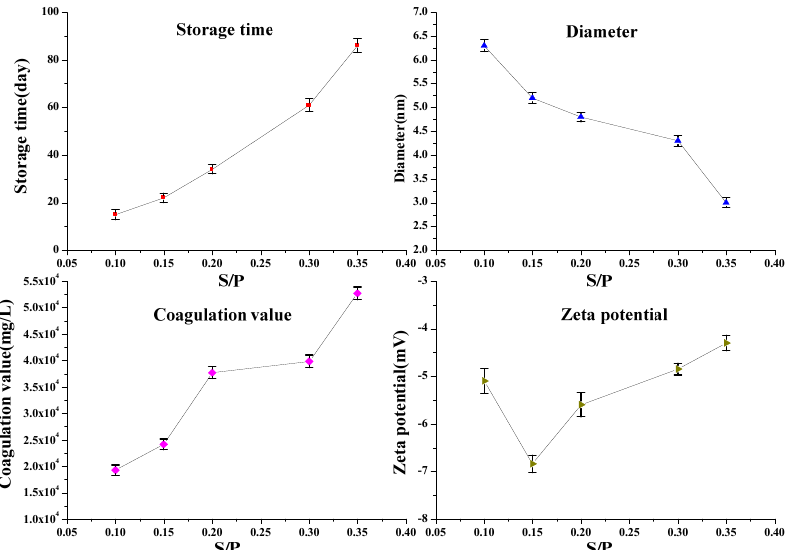
Figure 10. Effects of S/P on the SPF resin properties (mean ± s.d., n = 3 per condition).